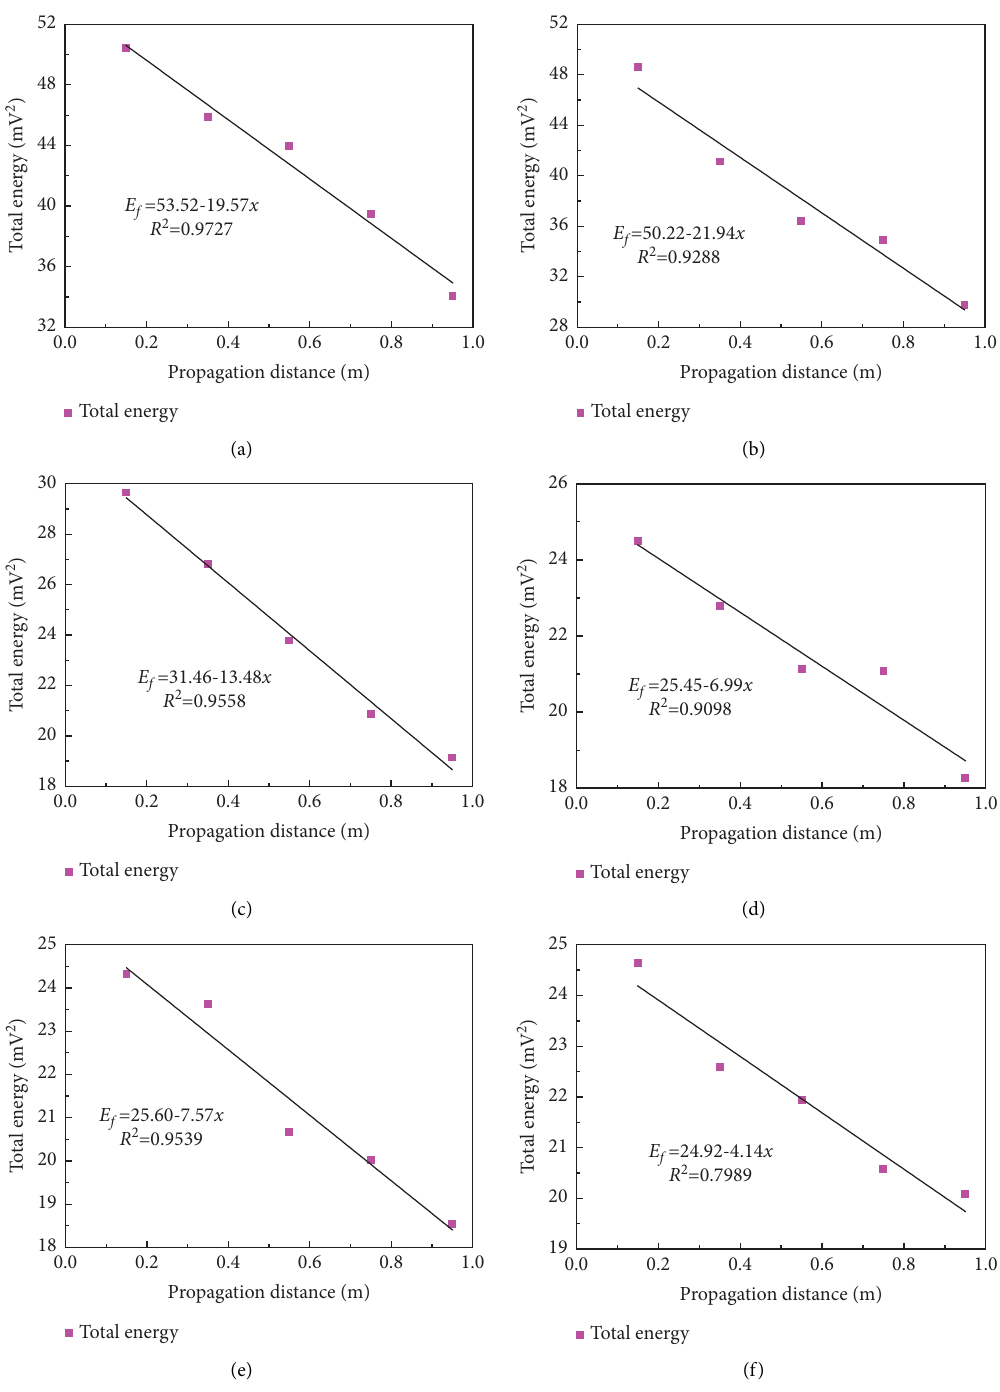
Figure 10: Total energy of frequency band. (a) 0 MPa. (b) 2.76MPa. (c) 11.04MPa. (d) 19.32MPa. (e) 27.60MPa. (f) 33.12